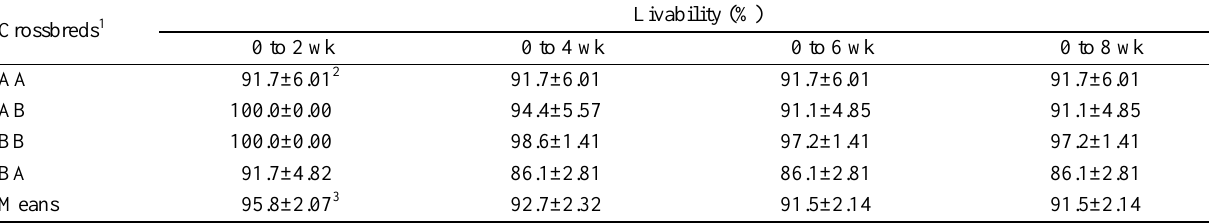
Table 2. Livability of commercial Korean native ducks during the experimental period Crossbreds 1